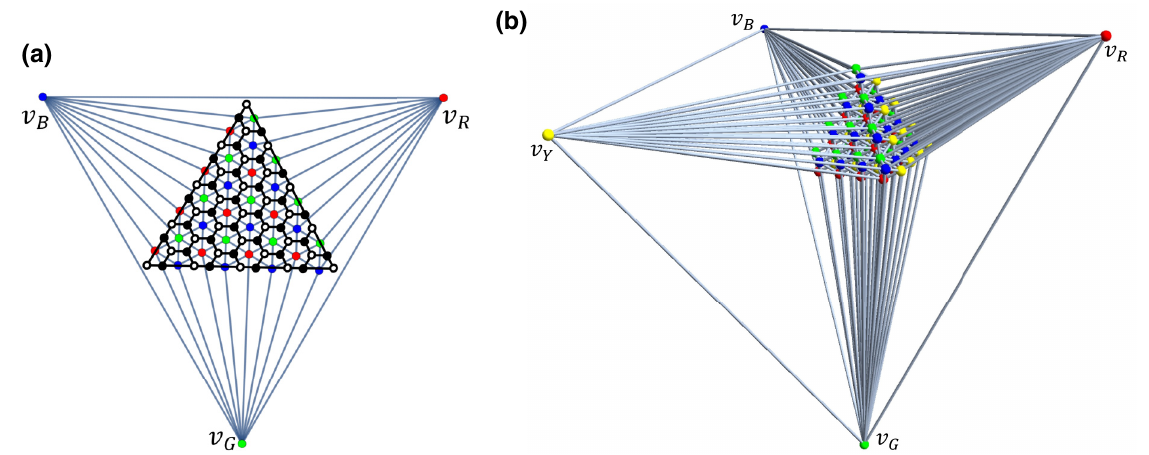
FIG. 5. Illustration of color-code lattices L 2D and L 3D for d = 9; see Appendix A for details. (a) The lattice L 2D (gray edges with (black edges, black and white vertices). Qubits are placed at triangles in R , G , and B vertices) and the corresponding primal lattice L ∗ 2D L L ∗ ), whereas X - and Z -stabilizer generators correspond to interior vertices in L 2D (faces in L ∗ 2D (vertices in 2D L 3D , qubits are identified with tetrahedra, whereas X - and Z -stabilizer generators correspond to interior vertices and interior edges, respectively. Note that L 2D can be obtained from L 3D by retaining only those vertices connected to the boundary vertex v Y along with the edges and faces containing only those